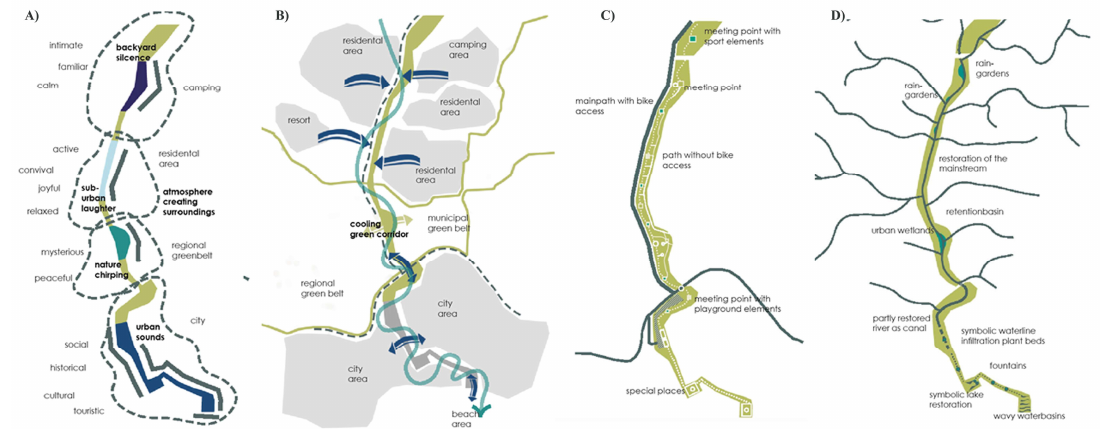
Figure 5. The representation of the atmosphere ( A ); green inking corridor ( B ); public spaces and path network ( C ); river restoration and the presence of water ( D ) in the four zones as defined by the strolling method.